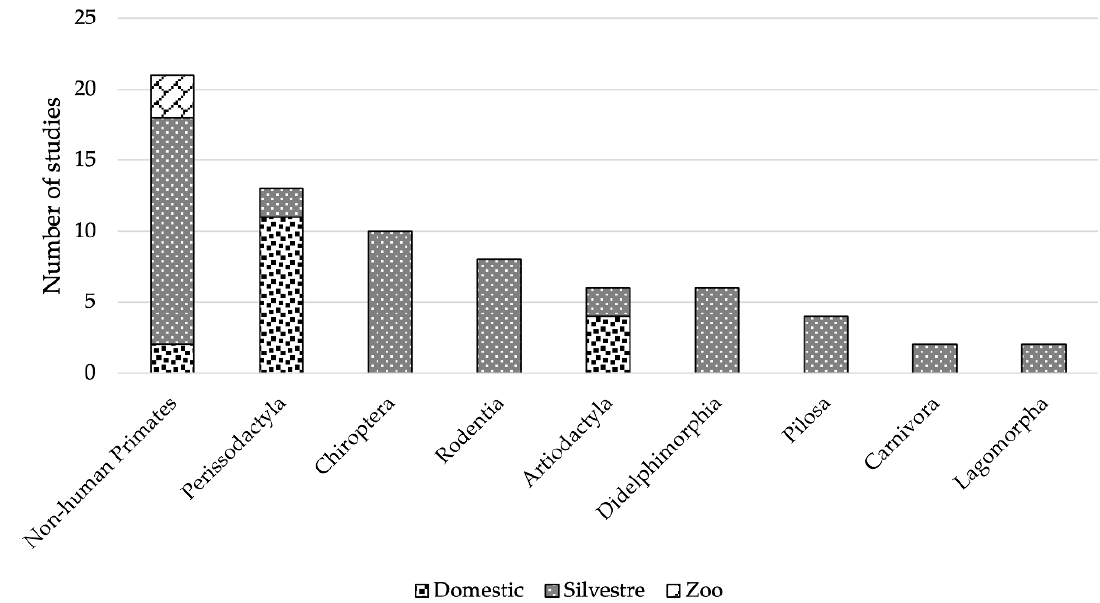
Figure 8. Sampling conditions by mammalian order in the Neotropics.